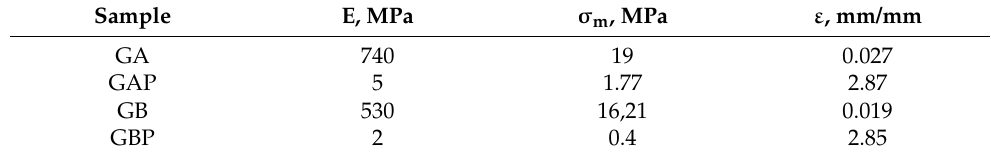
Table 3. Tensile strength ( σ ), elongation at break ( ε ) and elastic modulus (E) of the prepared films. Sample